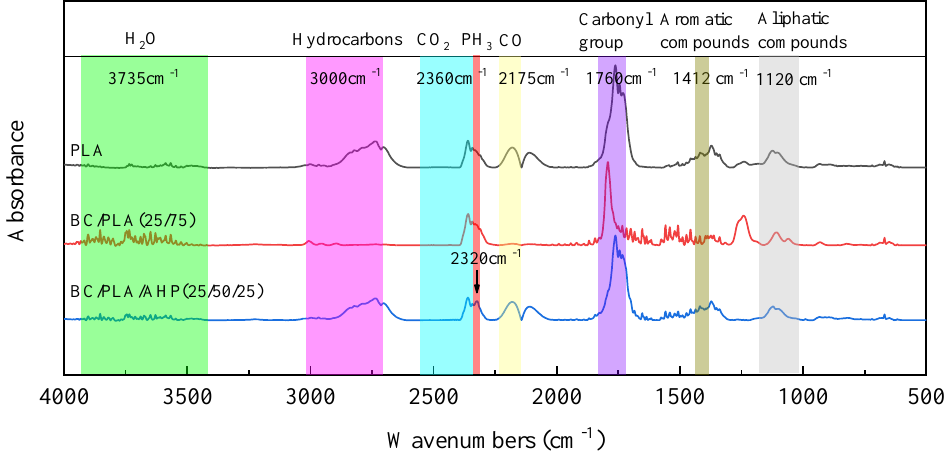
Figure 5. FTIR spectra of gas phase products of ( a ) PLA, ( b ) BC / PLA, and ( c ) BC / PLA / AHP at various temperatures.